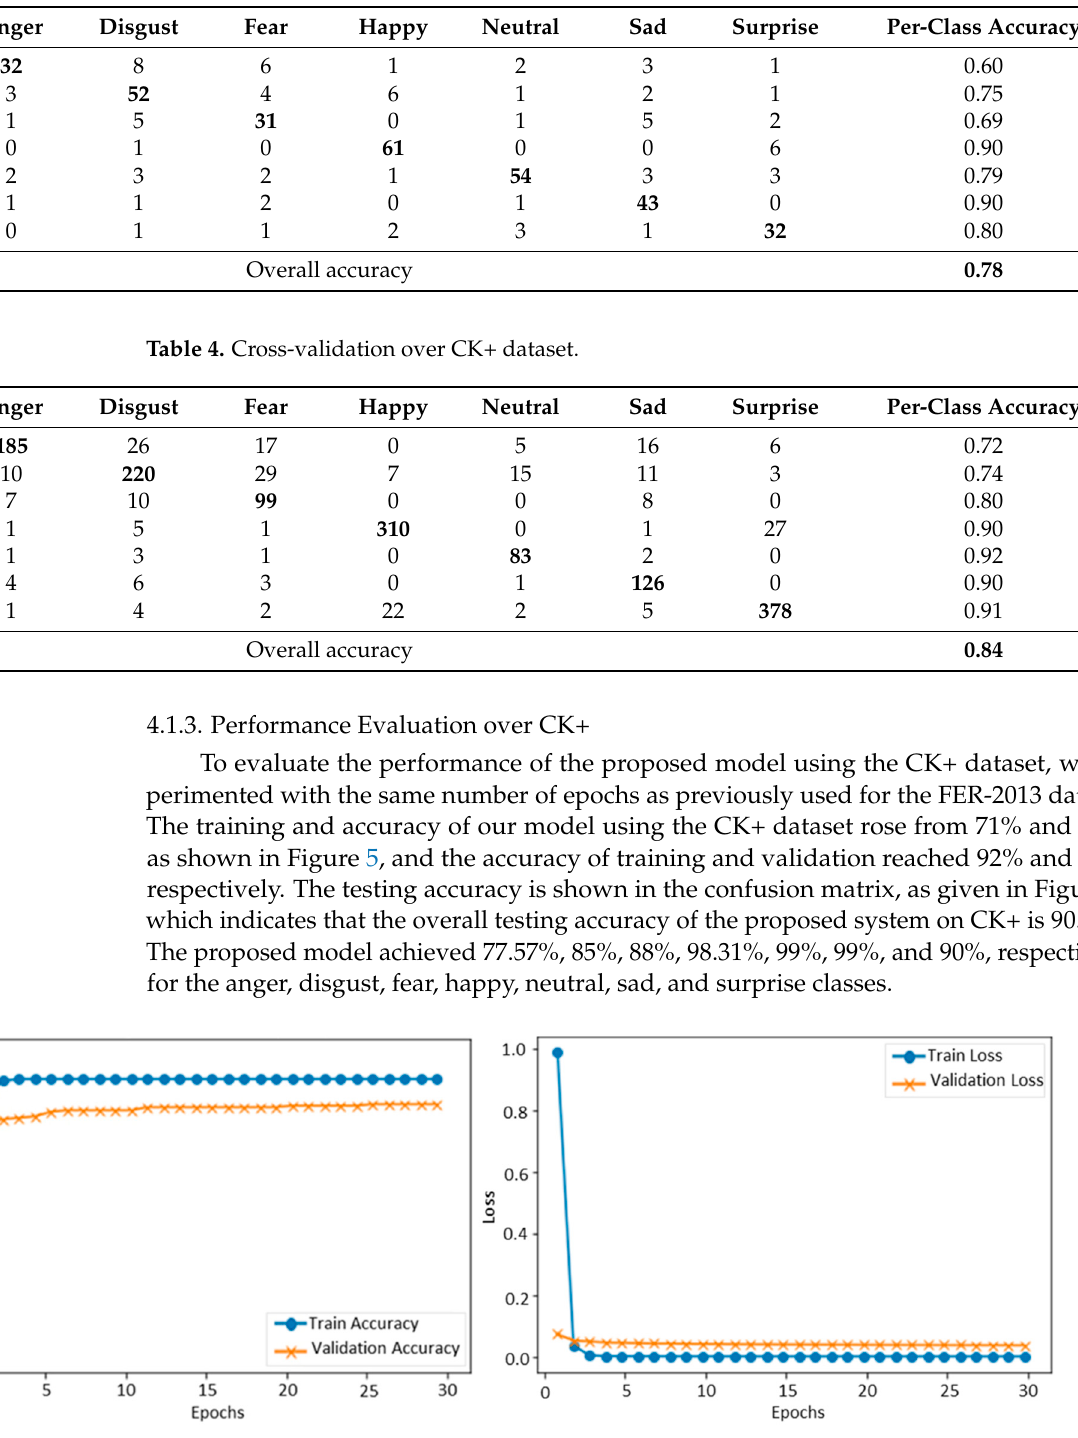
Table 3. Cross-validation over the KDEF dataset.